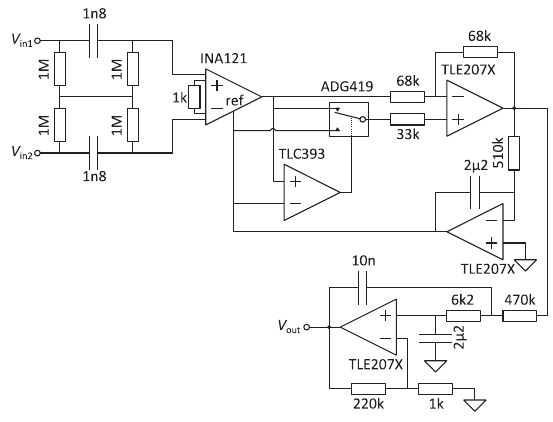
Fig.2: IPG voltage measurement system.